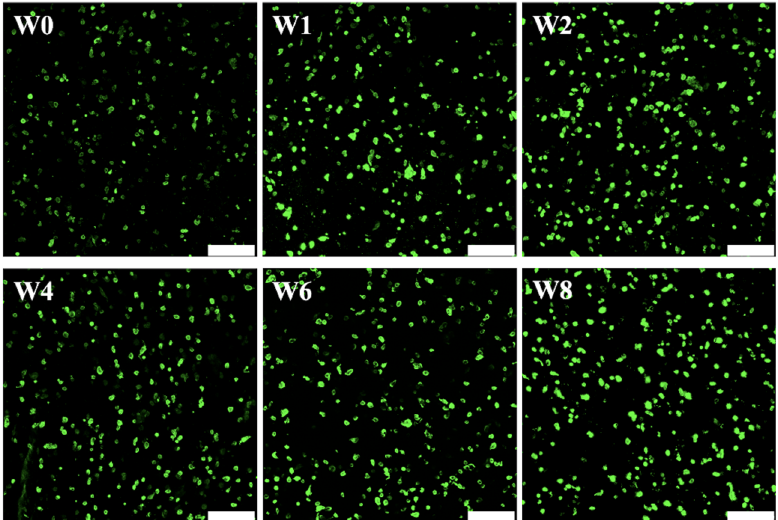
Figure 5. The fluorescent micrographs of the hGF-laden Col bio-ink before and after being cultured for different time-points. The scale bar is 200 µm.